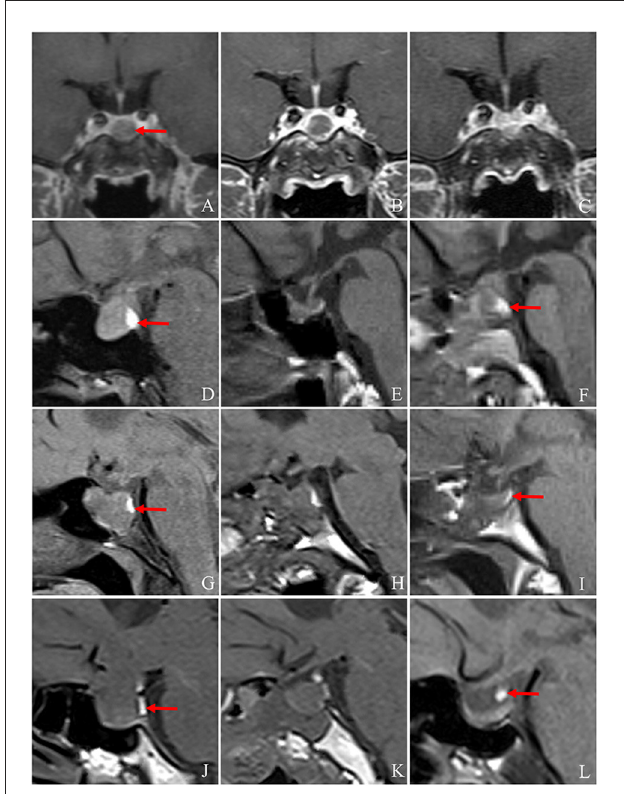
FIGURE1 Changes in the pituitary stalk and PPBS pre- and post-operatively. (A) The pituitary adenoma is located directly below the pituitary stalk (arrow) pre-operatively, and the pituitary stalk is centred without deviation. (B, C) MRI showed that the pituitary stalk was in the middle on the 6th day and the 4th month post-operation. (A–C) The pituitary stalk is centred on MRI pre- and post-operatively. (D–F) The PPBS of a 42-year-old female patient persisted pre-operatively and on the third day and at 4 months post-operatively, and the signal intensity decreased slightly post-operatively. The position of the posterior pituitary lobe decreased to the sellar base at 4 months post-operatively, and no obvious abnormality was found in the pituitary stalk (arrow indicates PPBS). (G–I) A 44-year-old female patient with persistent PPBS pre-operatively and on the 1st day and at 4 months post-operatively. The volume of PPBS decreased significantly. The position of the posterior pituitary lobe decreased to the sellar base 4 months post-operatively. No obvious abnormality was found in the pituitary stalk. The patient had no diabetes insipidus post-operatively (arrow indicates PPBS). (J–L) T1WI of a 59-year-old female patient pre-operatively, on the 2nd day post-operatively, and at 4 months post-operatively, respectively. Pre-operatively, two sections of PPBS are observed as being located behind the tumour. Post-operatively, PPBS is located in the lower part of the pituitary stalk, and its volume is larger than that pre-operatively. The patient did not have diabetes insipidus post-operatively (arrow indicates PPBS). MRI, magnetic resonance imaging; PPBS, posterior pituitary bright